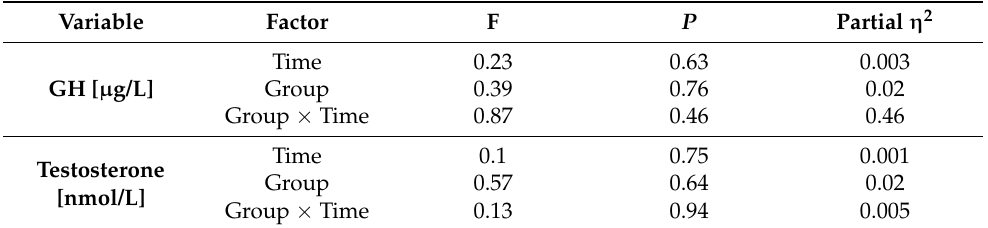
Table 5. Hormonal components of the four groups and relative significance levels and effect size (partial η 2 ). Statistically significant data are highlighted in bold. GH, growth hormone ( µ g/L); testosterone.